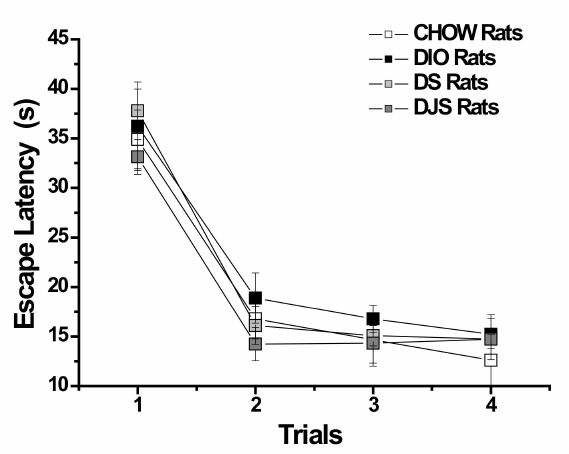
Figure 1. Morris water maze. Each trial shows the average (four trials each day) of the escape latency time taken to reach the platform on all 4 days of the test. Data presented as mean ± S.E.M.